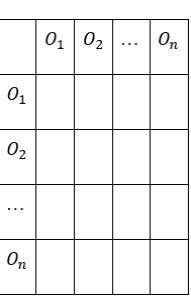
Figure 4. The structure of Origins-Origins OD matrix